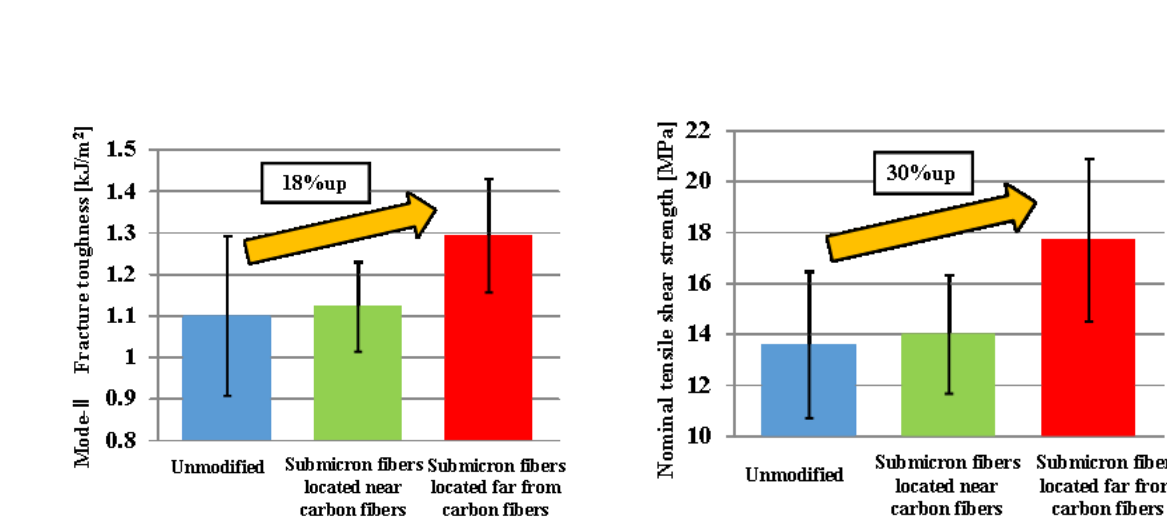
Figure 2: Geometry of ENF test and nominal tensile shear test.